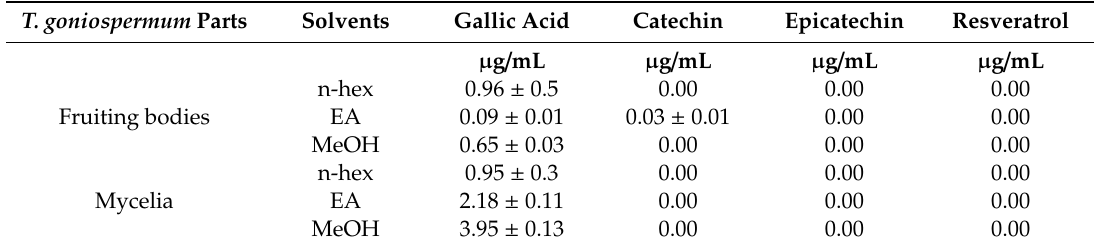
Table 1. Phenolic compounds in n-hx, EtOAc, MeOH extracts of Tricholosporum goniospermum fruiting bodies and mycelia.